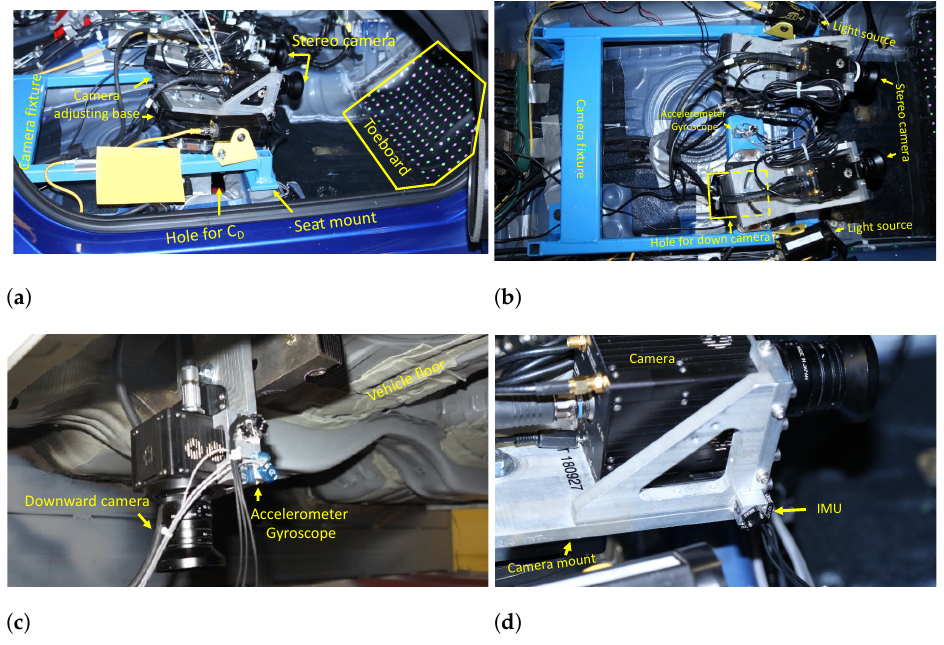
Figure 6. Sensor suite for real car test: ( a ) side view; ( b ) top view; ( c ) bottom view; ( d ) close-up view of camera and IMU